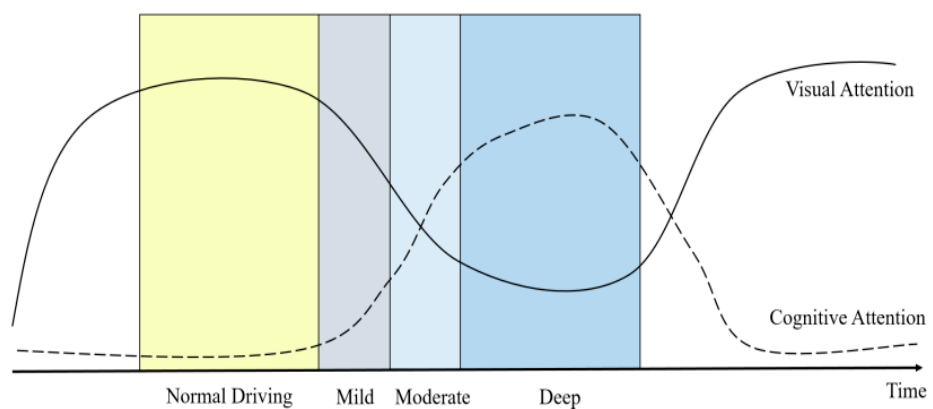
Figure 9. Schematic diagram of the competition between visual and cognitive attention under di ff erent states. different states.